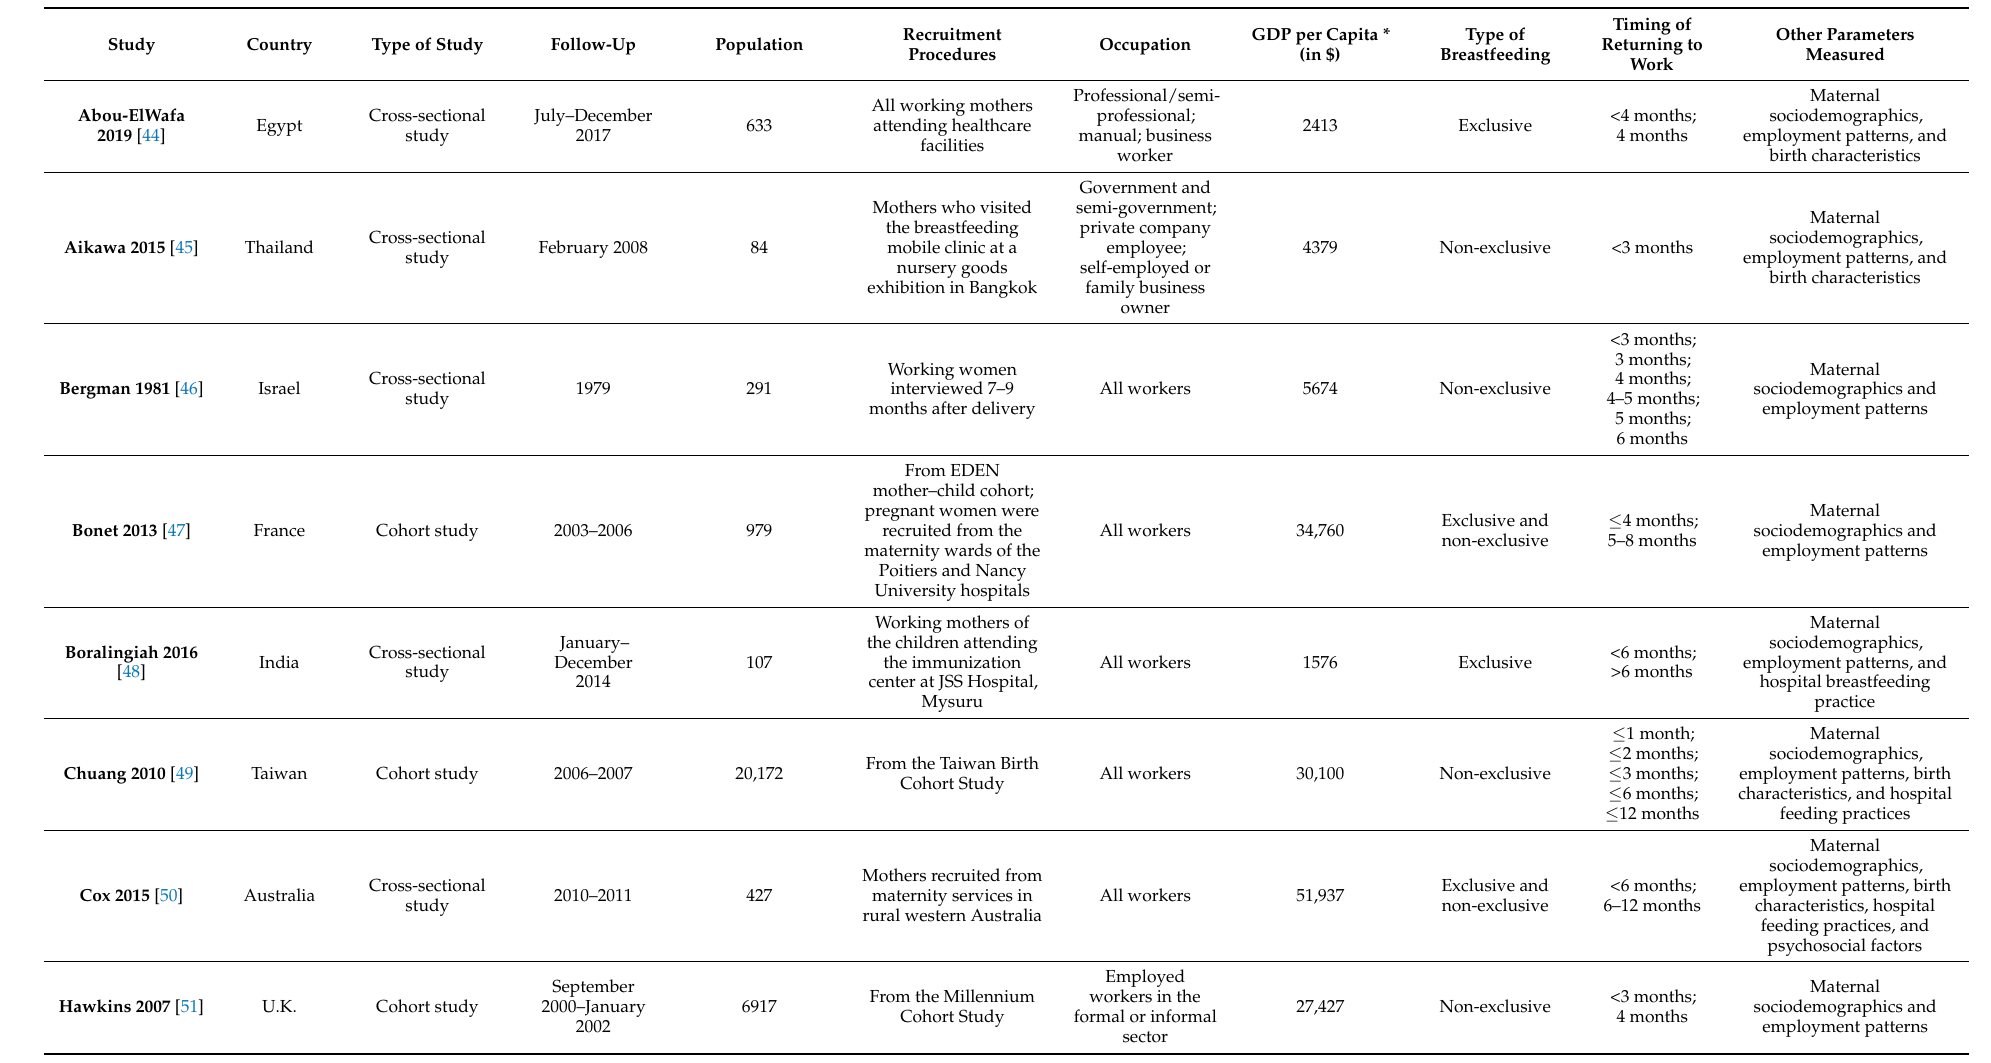
Table 1. Characteristics of included studies. * Adjusted by years of the